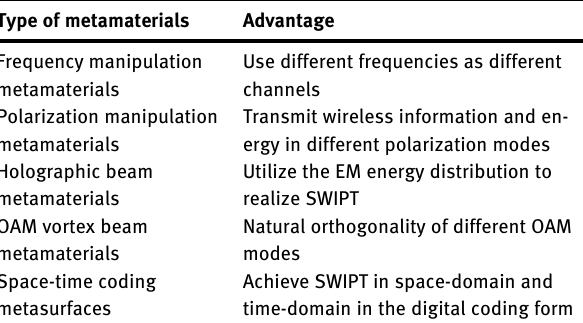
Figure 30: Conceptual illustration of thejoint multi-frequencybeam forming and steering via an STCM [131]. Reprinted from [131], with the permission of John Wiley and Sons Publishing. © 2020 Wiley ‐ VCH GmbH.